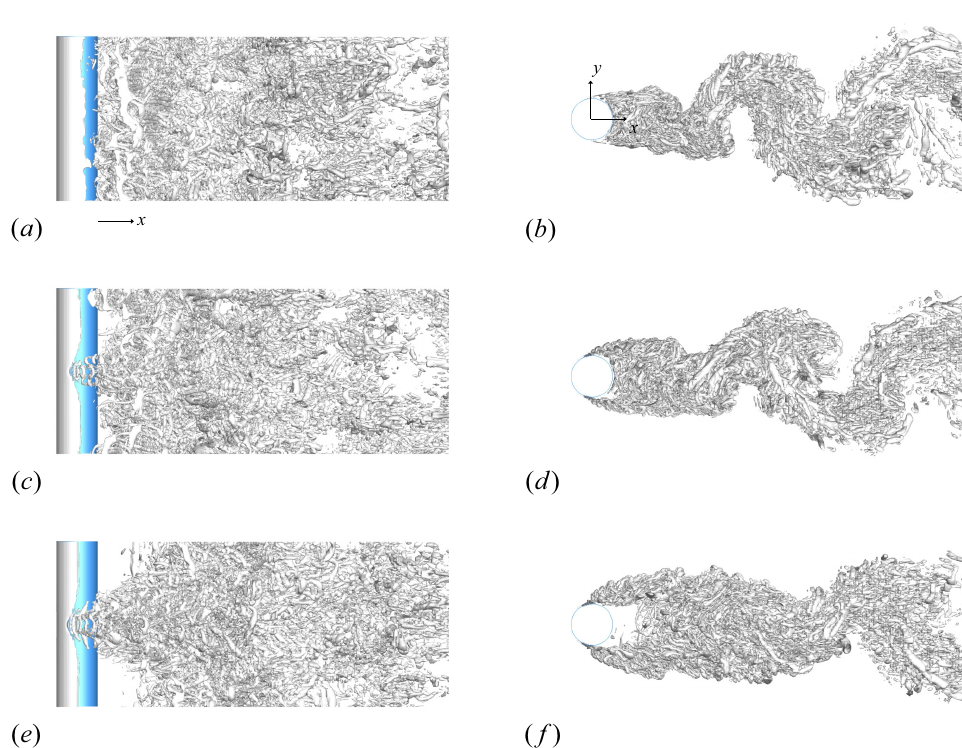
Figure 7. Instantaneous vortical structures over a circular cylinder with and without tabs identi- fied using the λ 2 method [50] in top view (left) and in side view (right): ( a , b ) cylinder without a tab; ( c , d ) cylinder with tabs of l y / d = 0.2 and l z / d = 0.1; ( e , f ) cylinder with tabs of l y / d = 0.2 and l z / d = 0.3.